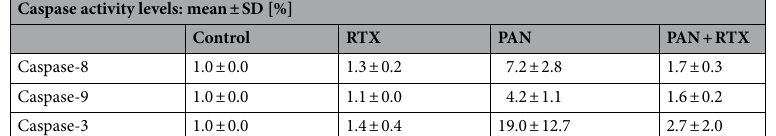
Caspase activity levels: mean ± SD [%] Control